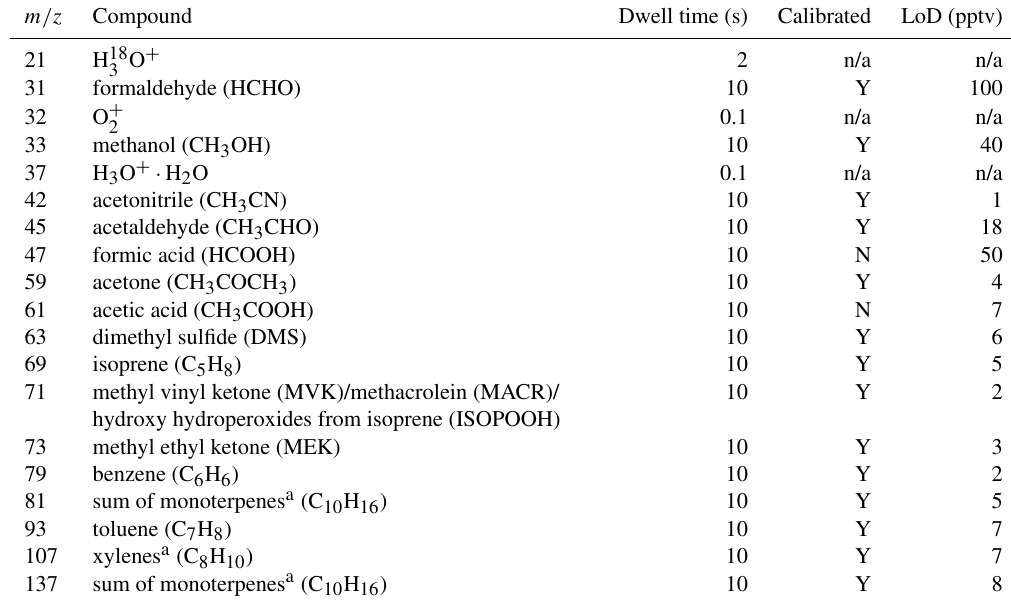
Table 2. A list of mass-to-charge ratios ( m/z ) observed in multiple ion detection mode by the hs-PTR-MS at RUN with the associated chemical compounds, dwell times and information about the instrument calibration limit of detection (LoD) per compound (Y: yes, N: no, n/a: not applicable). Dwell time is shown for one cycle. The LoD is computed for the hourly averages used here. The corresponding accumulated dwell times are about 22 times the stated dwell times of an individual cycle. m/z Compound Dwell time